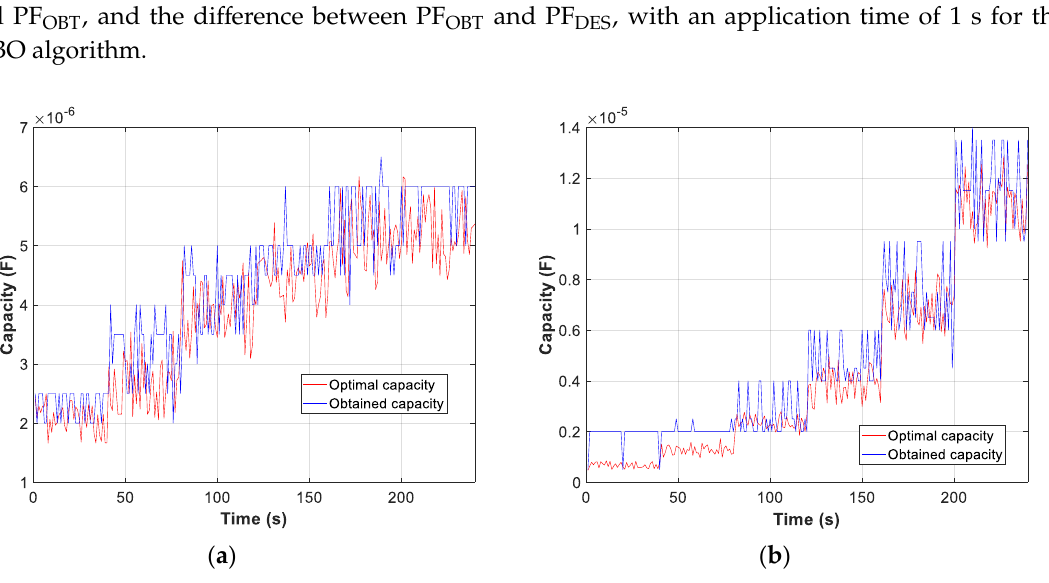
( b ) Figure 18. Comparison PF INST vs PF OBT : ( a ) Series connection; ( b ) Parallel connection. Figure 19. Difference between PF OBT and PF DES . The difference between PF OBT and PF DES , for series and parallel loads, is less than 0.050. The results obtained with the TLBO algorithm indicate the correct operation for different loads.